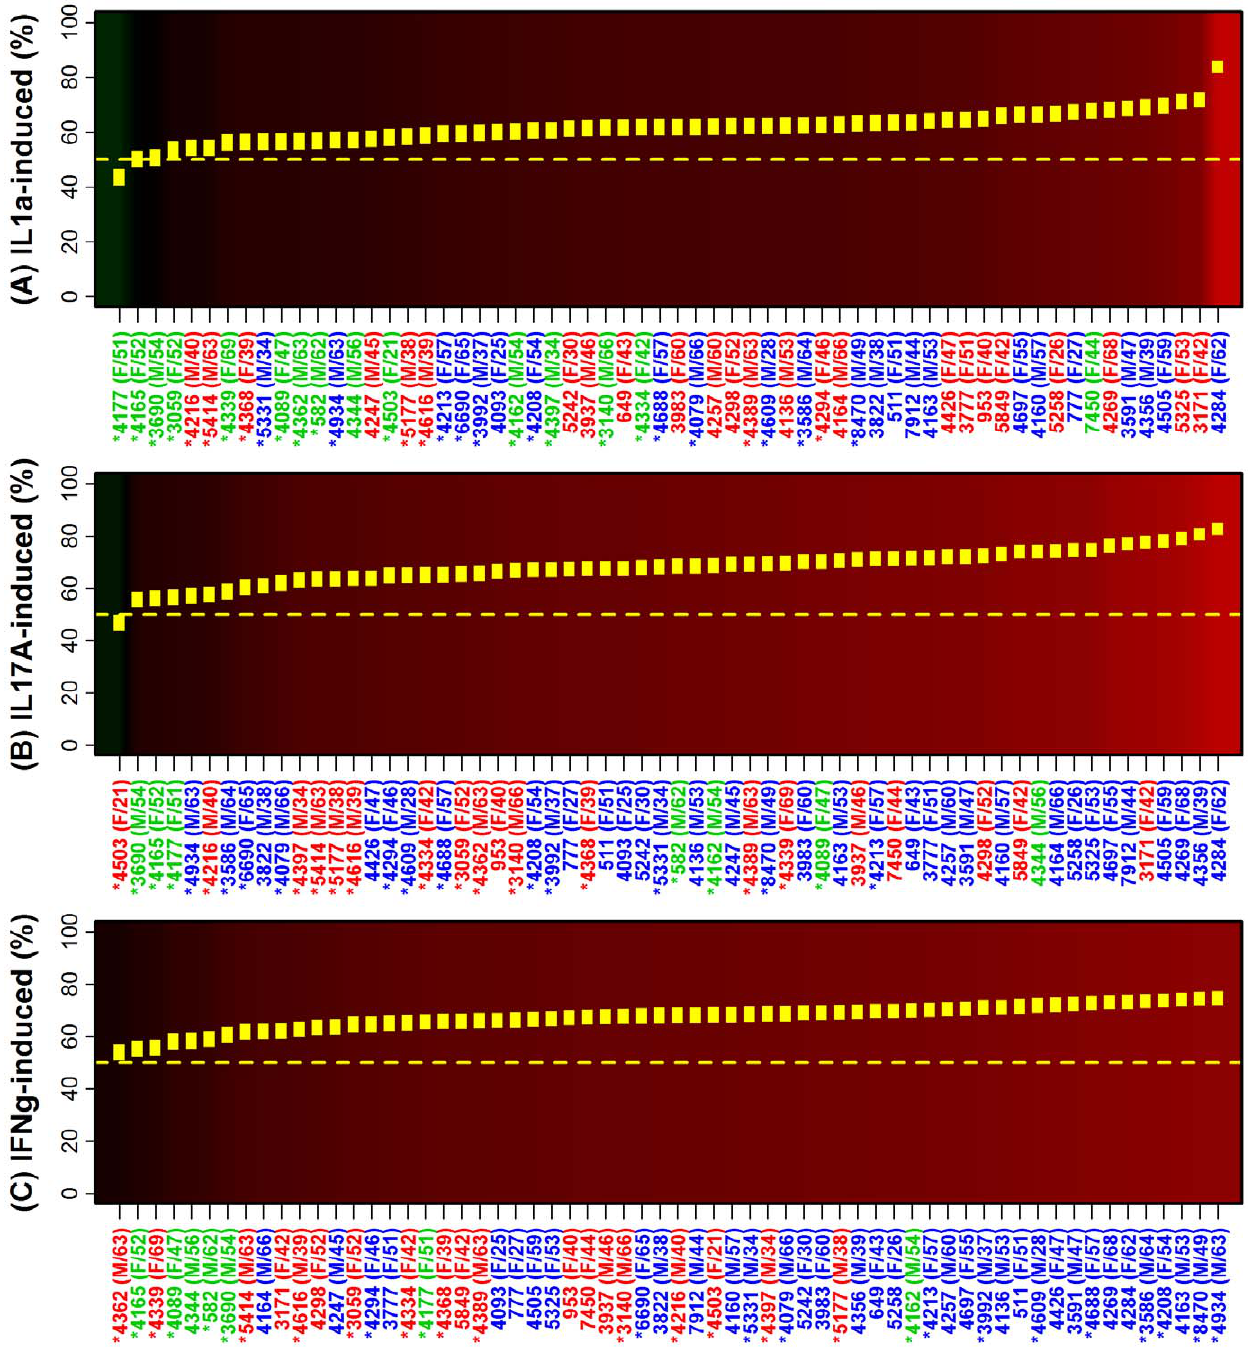
Figure 4. Distribution of IL1- a , IL-17A and IFN- c gene expression signatures among lesional skin samples from 62 patients. We identified three sets of 1000 transcripts that were (A) induced by IL1- a treatment of cultured keratinocytes, (B) induced by IL-17A treatment of keratinocytes and (C) induced by IFN- c treatment of keratinocytes. For each set and patient, we calculated the percentage of transcripts elevated in lesional (PP) samples as compared to paired non-lesional (PN) samples. In (A)–(C), subjects are ordered according to the estimated proportion of cytokine-responsive transcripts elevated in PP skin relative to PN skin (as described in the Figure 3 legend).